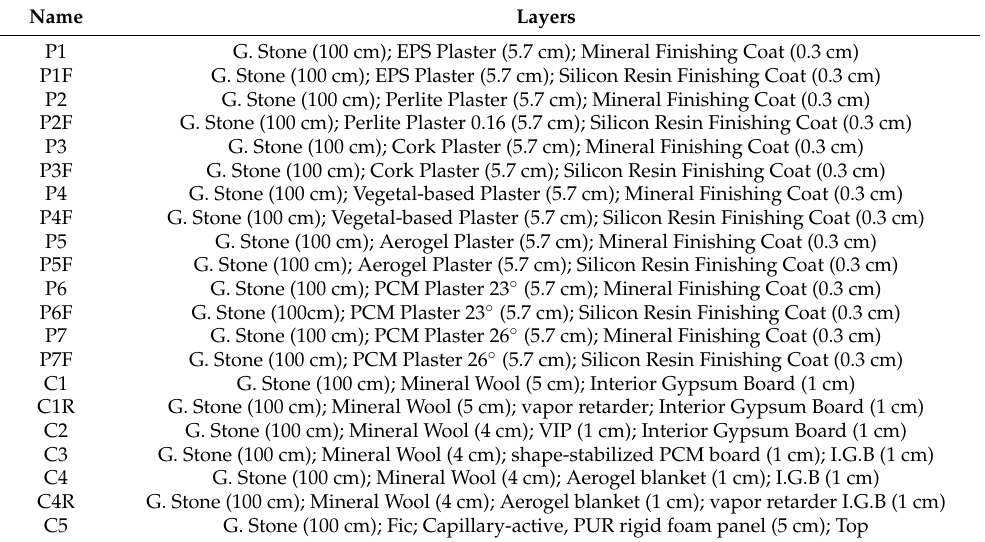
Table 1. Thermal plaster-based assemblies (P) and Counter wall-based assemblies (C) from the outside to the